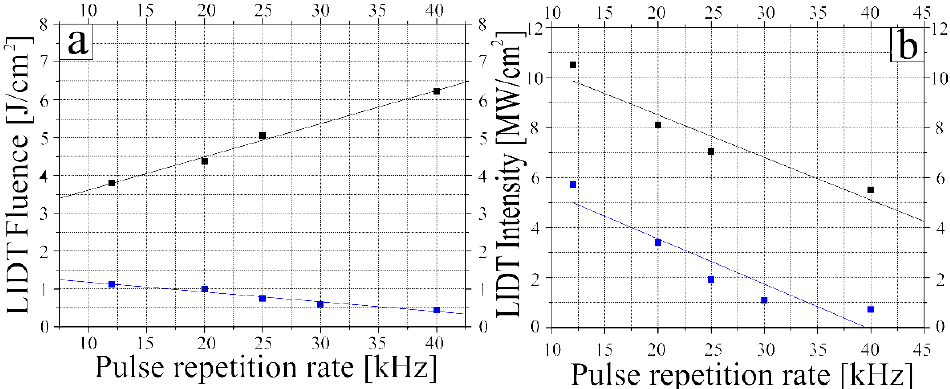
Figure 9. LIDT fluence ( a ) and LIDT peak intensity ( b ) vs. PRR for the N1 sample (blue) and the N2 sample (black). All LIDT parameters were determined at the 0-probability of LIDT. The exposure duration and the beam diameter were 1 s and 180 µm, respectively.